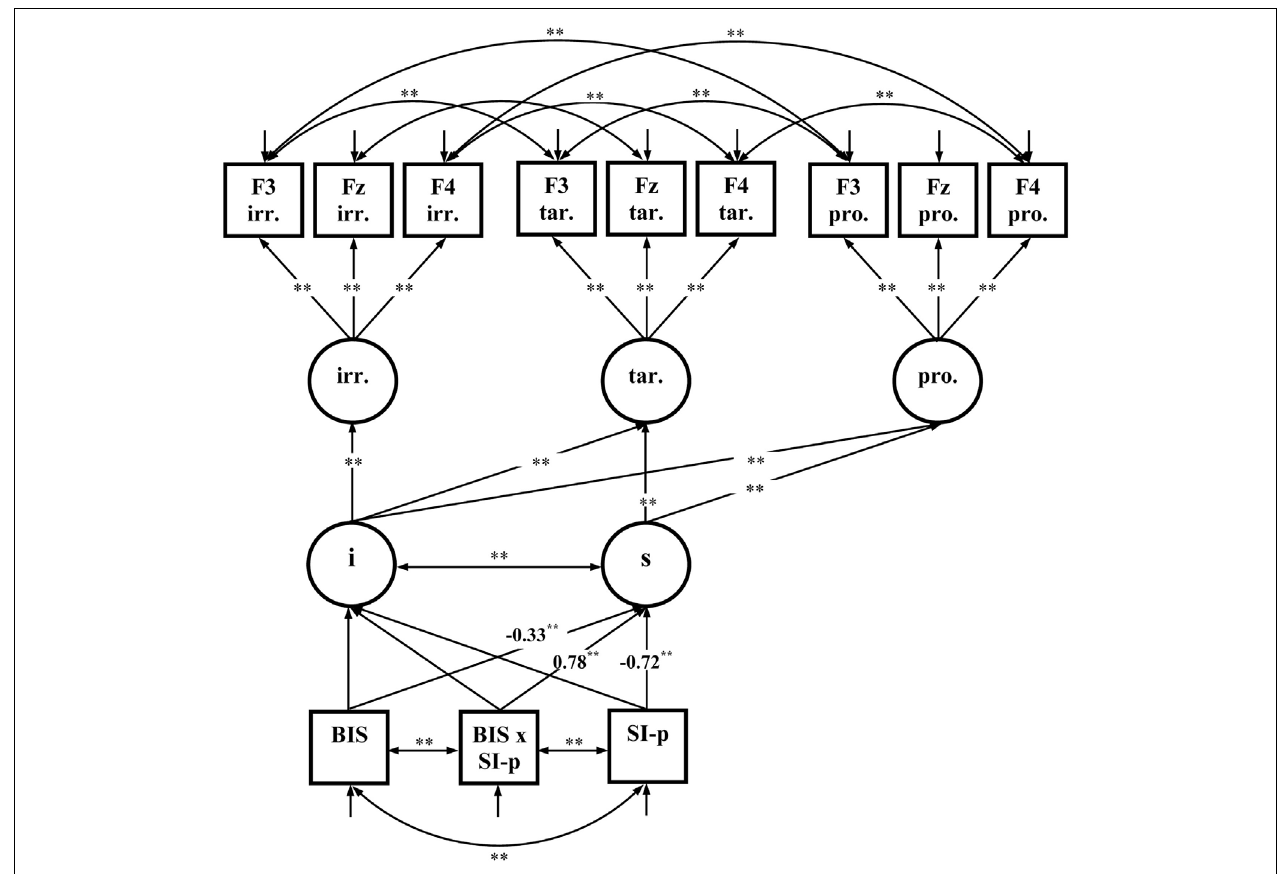
convenience, numerical values of the completely standardized solution are only given for significant coefficients related toTrait-BIS (BIS), SI-perpetrator (SI-p), and theTrait-BIS × SI-perpetrator interaction (BIS ×